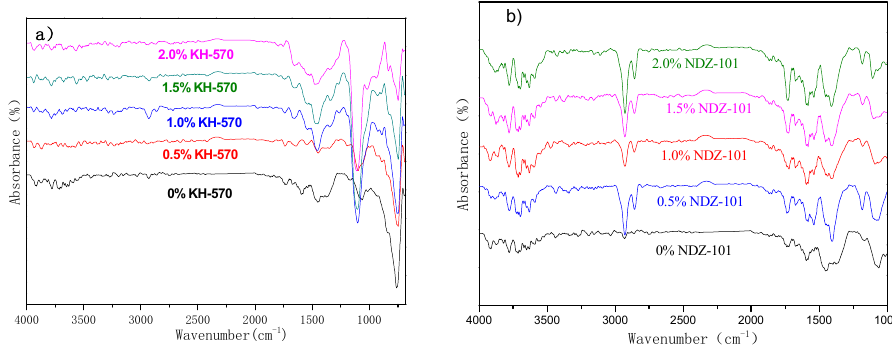
Figure 1. FTIR (Fourier Transform infrared spectroscopy) spectra of piezoelectric ceramic transducer (PZT) with surface treated and untreated by coupling agent.